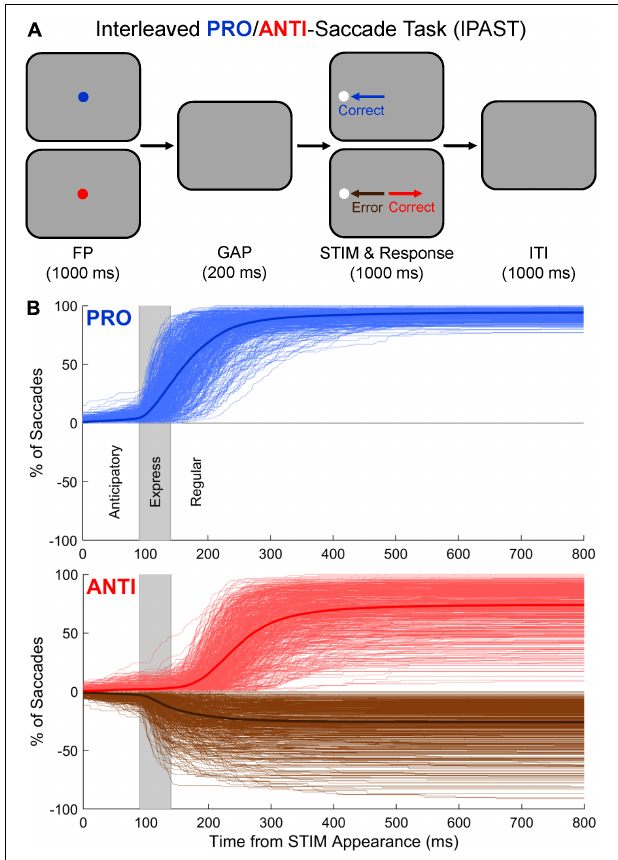
FIGURE 1 | (A) Visual representation of the Interleaved PRO/ANTI-Saccade Task (IPAST). Each trial began with the appearance of a fixation point (FP) in the center of a black screen for 1000 ms. The color of the FP indicated the trial condition (green = PRO, red = ANTI). Following a 200 ms gap (GAP) during which the FP was removed, a gray stimulus (STIM) appeared 10 ◦ to the left or right of the FP position and remained on screen for an additional 1000 ms. On PRO trials, participants were instructed to look at the STIM as soon as it appeared. On ANTI trials, participants were instructed to look away from the STIM as soon as it appeared. Direction errors were saccades made toward the STIM on ANTI trials. An inter-trial interval (ITI) was presented for 1000 ms before the start of each new trial. Note that for illustration purposes, the colors of the FP, screen, and STIM shown in panel (A) differ slightly from how the task would appear to participants in the lab. (B) Cumulative SRT distributions for PRO and ANTI trials. On PRO and ANTI trials, saccades were classified based on when they occurred and their start and end positions. Saccades made toward the two potential STIM locations occurring between –110 and 89 ms relative to STIM appearance were considered “anticipatory” and excluded from further analysis. Saccades made toward the two potential STIM locations occurring between 90 and 800 ms relative to STIM appearance were considered “viable” and further delineated based on their latencies. PRO viable correct responses and ANTI viable direction errors were divided into express (90–139 ms) and regular (140–800 ms) latencies. Thick lines are averaged distributions for the entire study cohort. Thin lines are individual participants. Vertical gray windows indicate the express-latency epoch.